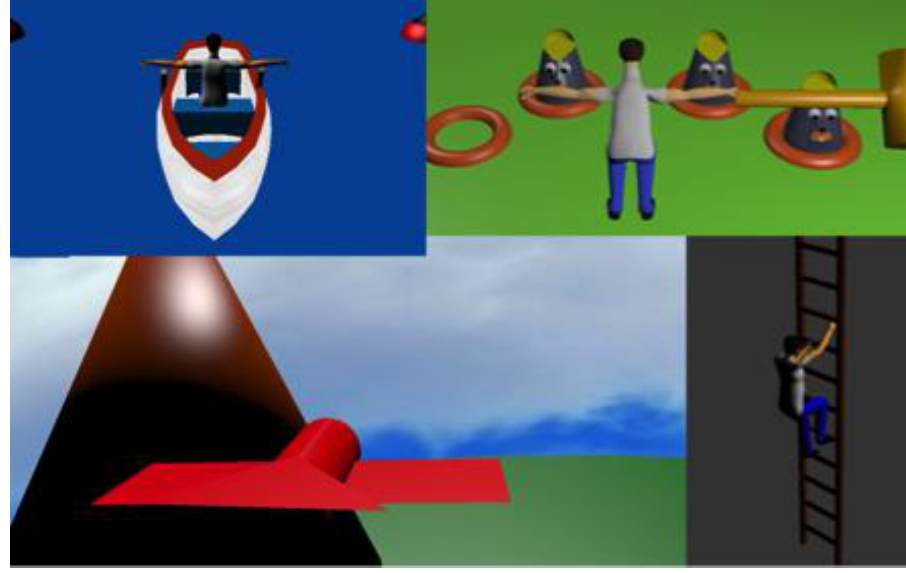
Figure 6. Visualization of the four mini-games (from left to right, top down): “The Boat”, “Whack-a-Mole”, “The Paper-Bird”, and “The Ladder”.